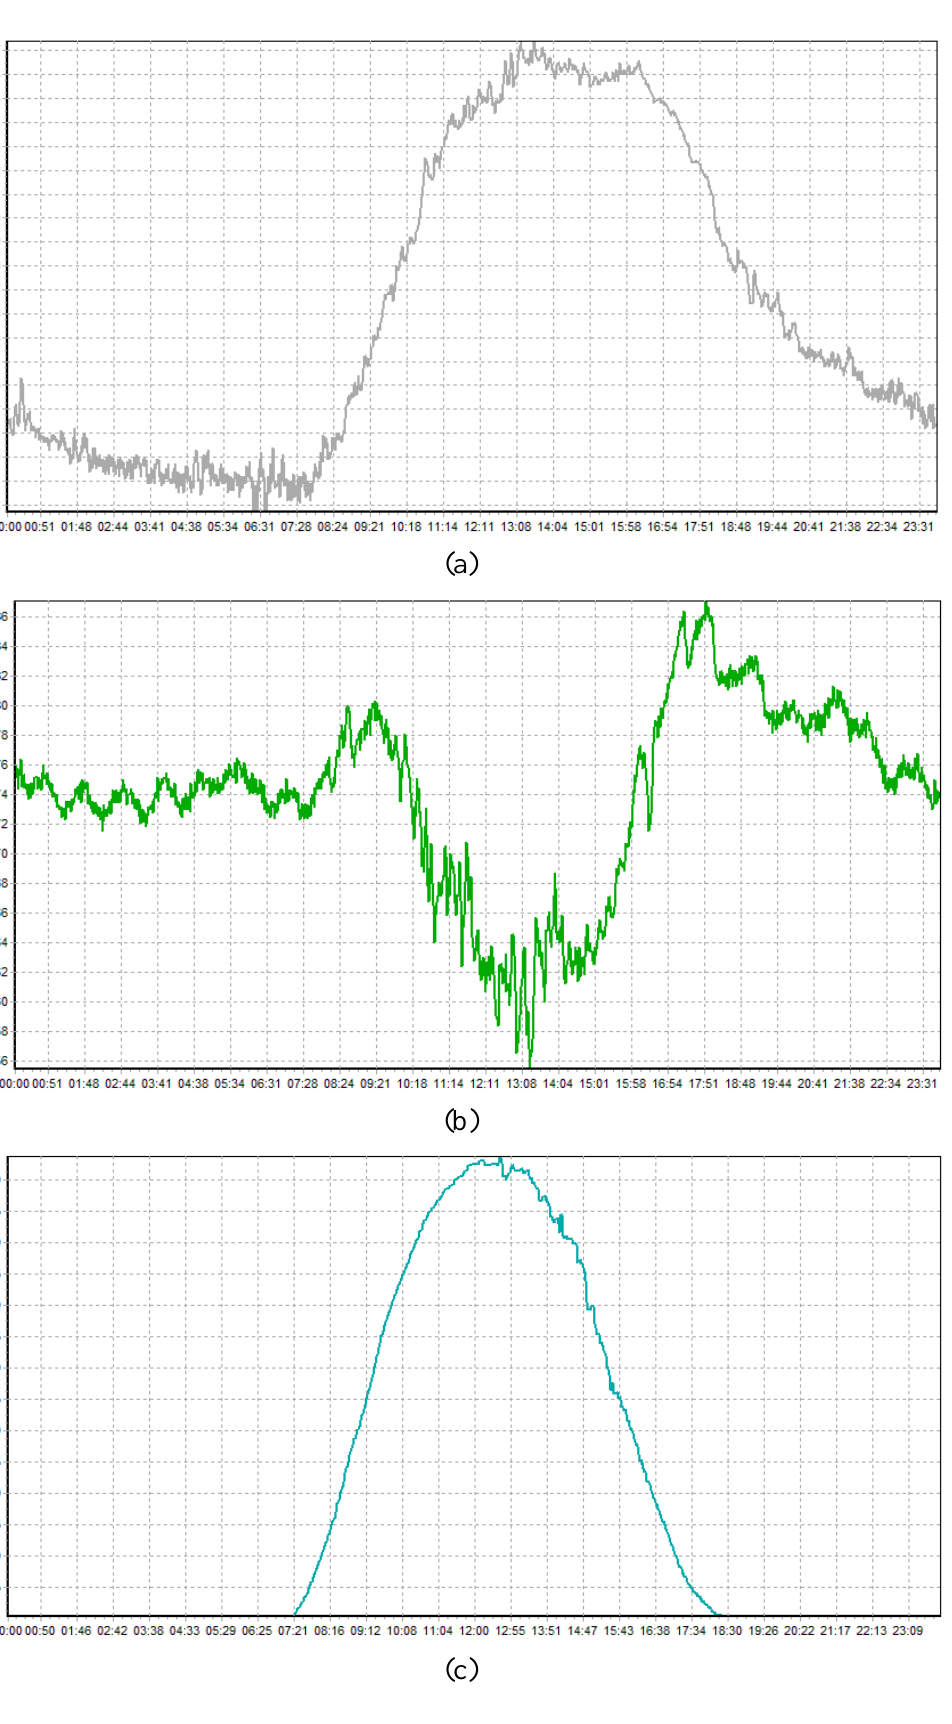
Figure 19. Measured Environmental Data Graph. (a) Temperature Graph (2010.02.23); (b) Humidity Graph (2010.02.23); (c) Luminance Graph